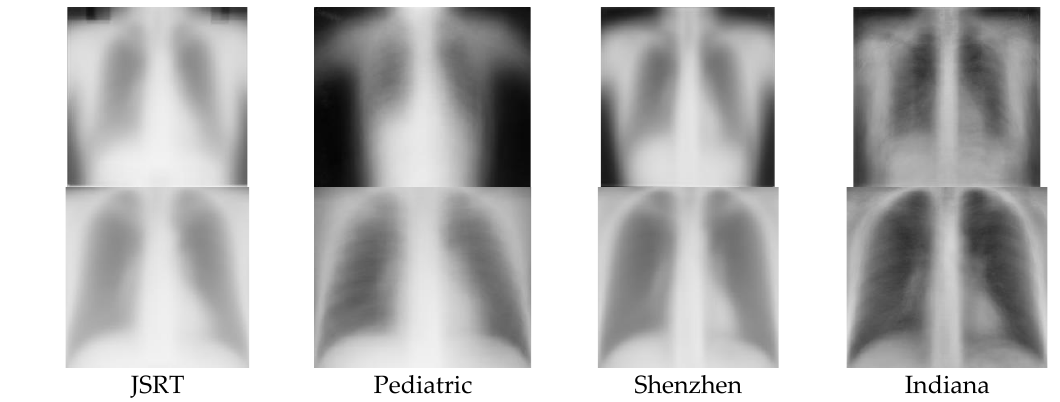
Figure 3. Average image of each dataset (1st row: whole image; 2nd row: cropped image).